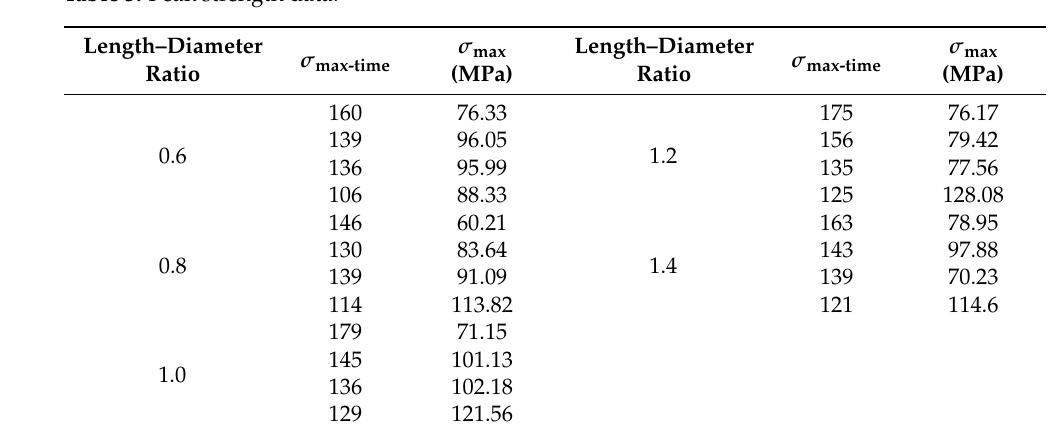
Table 3. Peak strength data.